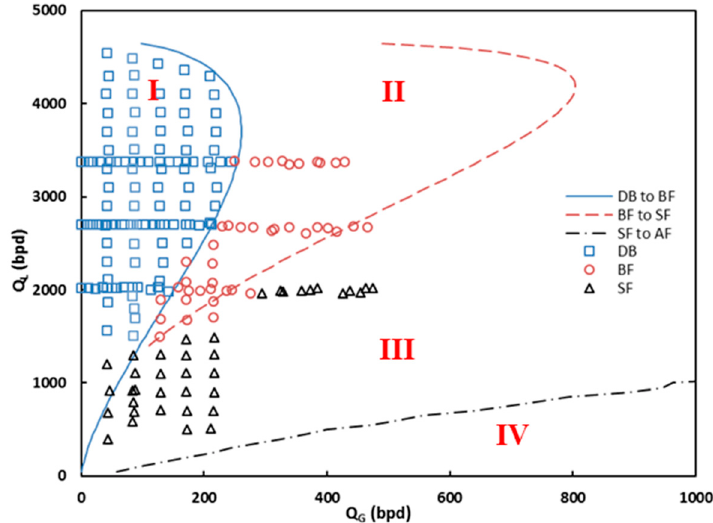
Figure 18. Validation of mechanistic model for predicting the flow pattern transition boundary in ESP under gas/liquid flow [1].